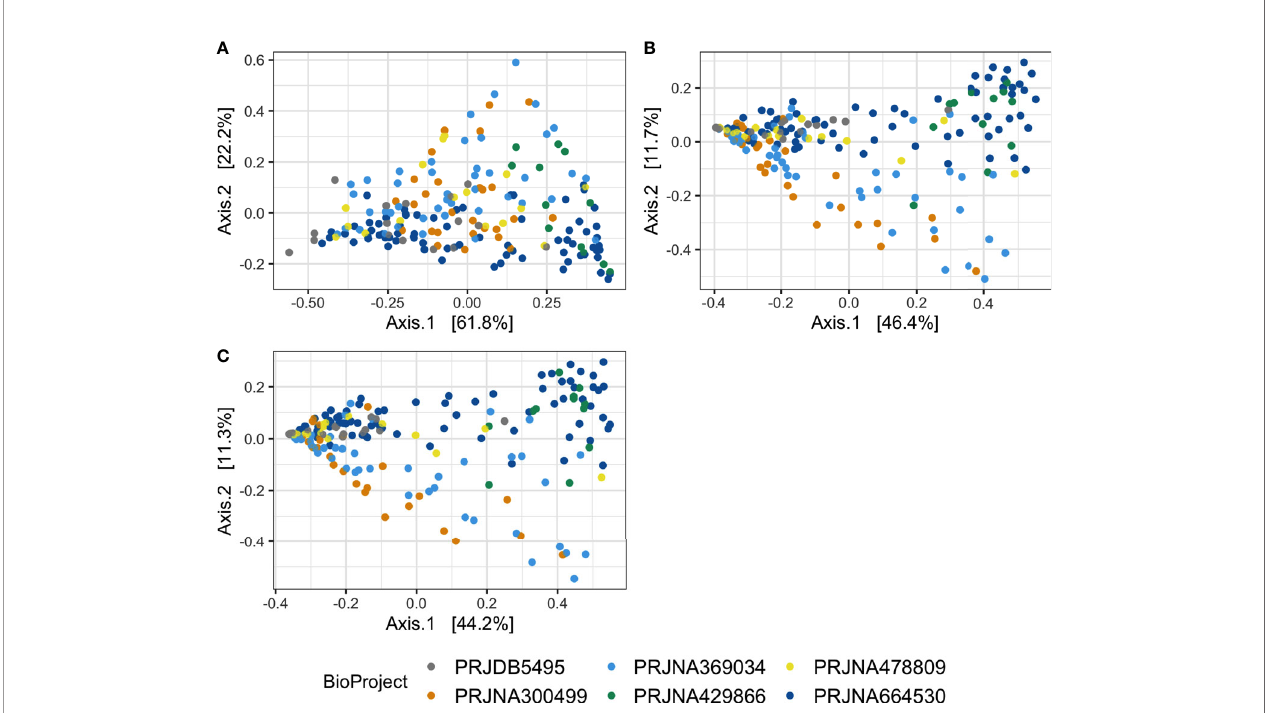
FIGURE 4 | Principal coordinates analysis on Bray-Curtis distances of DD positive skin microbiota. Bray-Curtis distances were calculated on DD positive skin samples in which ASVs were grouped at (A) phylum, (B) family, and (C) genus level classi fi cations.